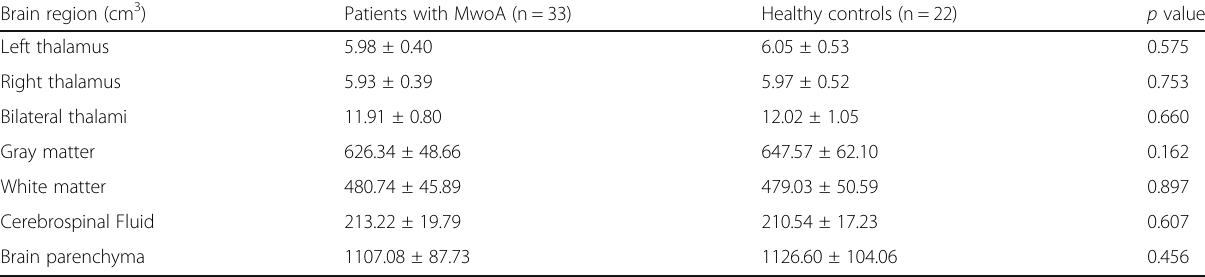
Table 2 Comparisons of volumes between patients with MwoA and healthy controls Brain region (cm 3 ) Patients with MwoA (n = 33) Healthy controls (n =